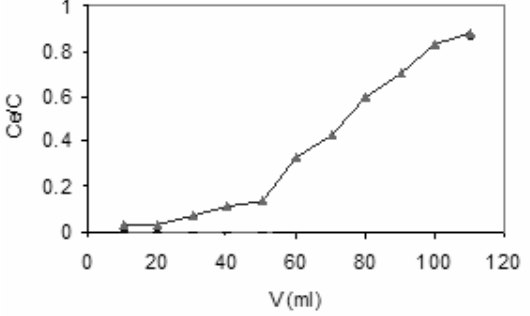
Figure 10 . Breakthrough curves obtained for PANi/SD